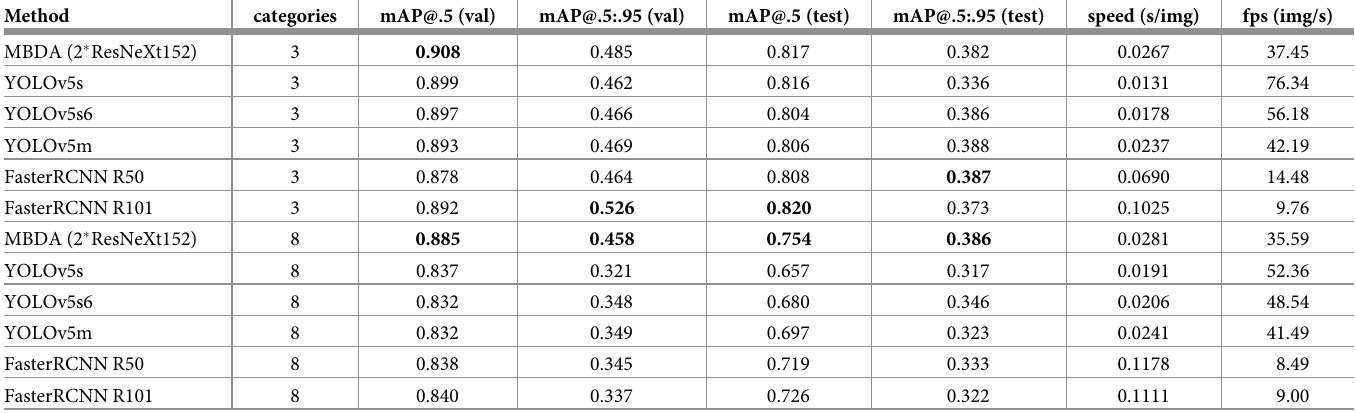
Table 1. Detection results of different methods over the rail defect